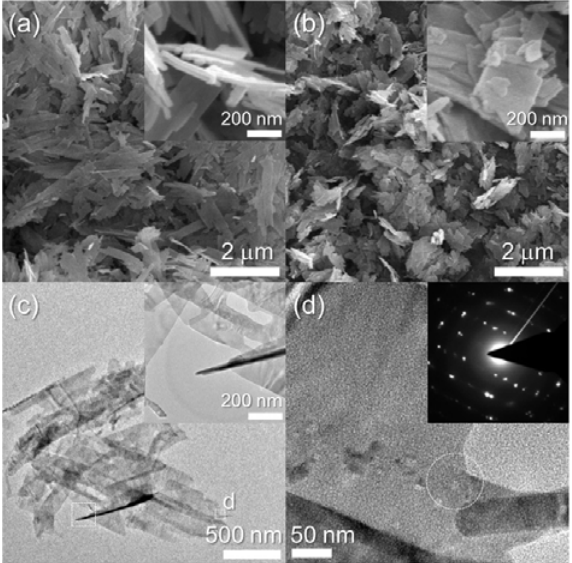
Figure 2. SEM and TEM images of CuO nanosheets. ( a ) SEM image of as-prepared CuO nanosheets, ( b ) SEM image of CuO nanosheets after heat treatment at 500 °C for 1 h , and ( c , d ) TEM images and SAED pattern of CuO nanosheets after heat treatment at 500 °C for 1 h .